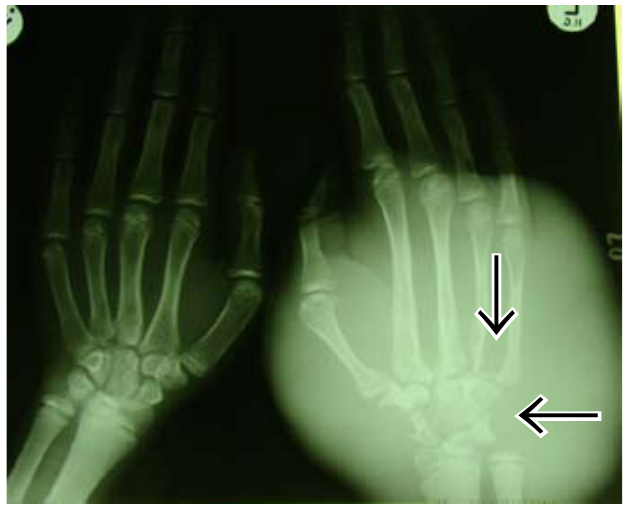
Fig. 16a. Frontal X-ray of the hands showing large plexiform neurofibroma causing focal enlargement, elongation, thinning of the metacarpals and pres- sure changes (scalloping) of the bases of the metacarpals and carpal bones, also called a